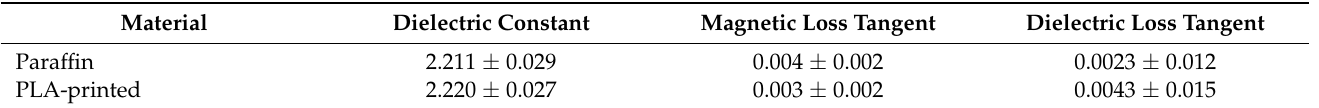
Table 3. Calculated dielectric constant and loss tangent of the paraffin and PLA.